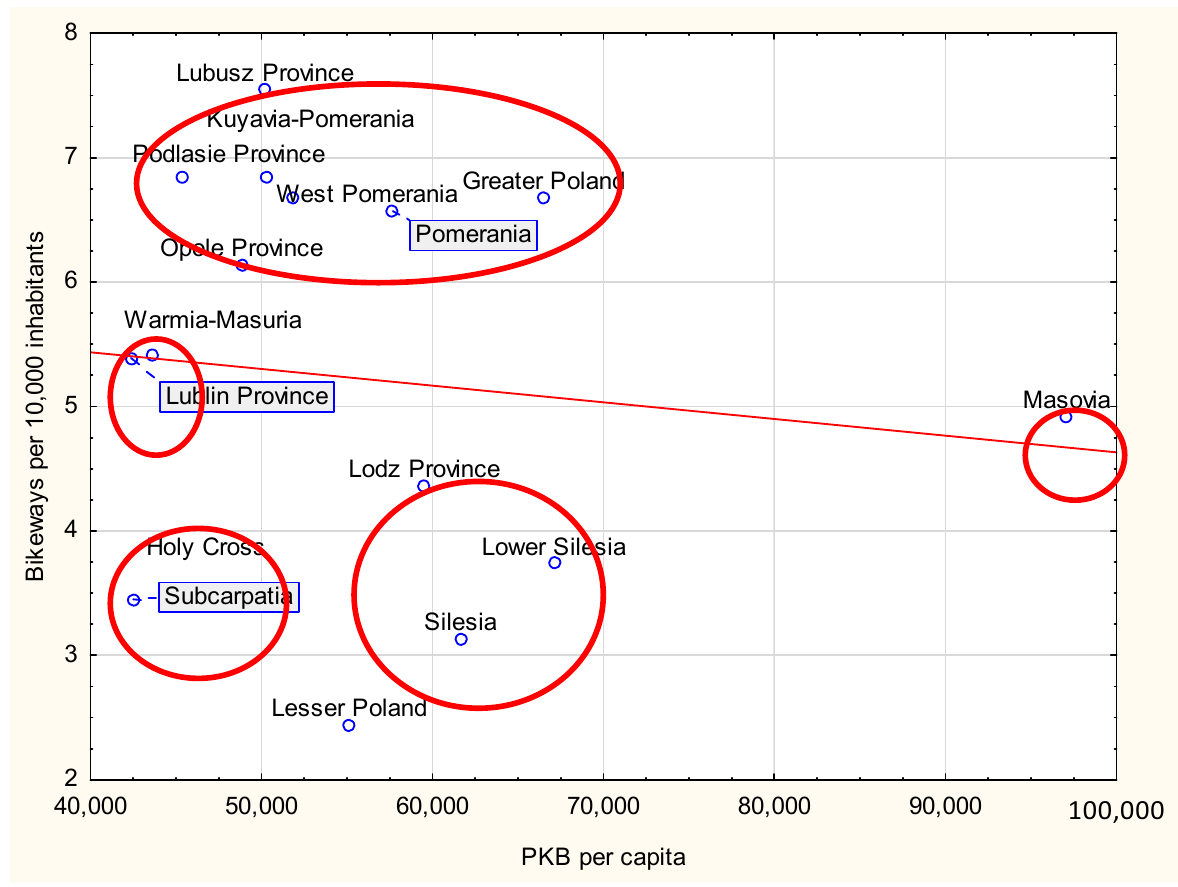
Figure 6. Relationship between the length of bicycle paths per 10,000 inhabitants in a province and GDP per capita. Source: Author own analysis.